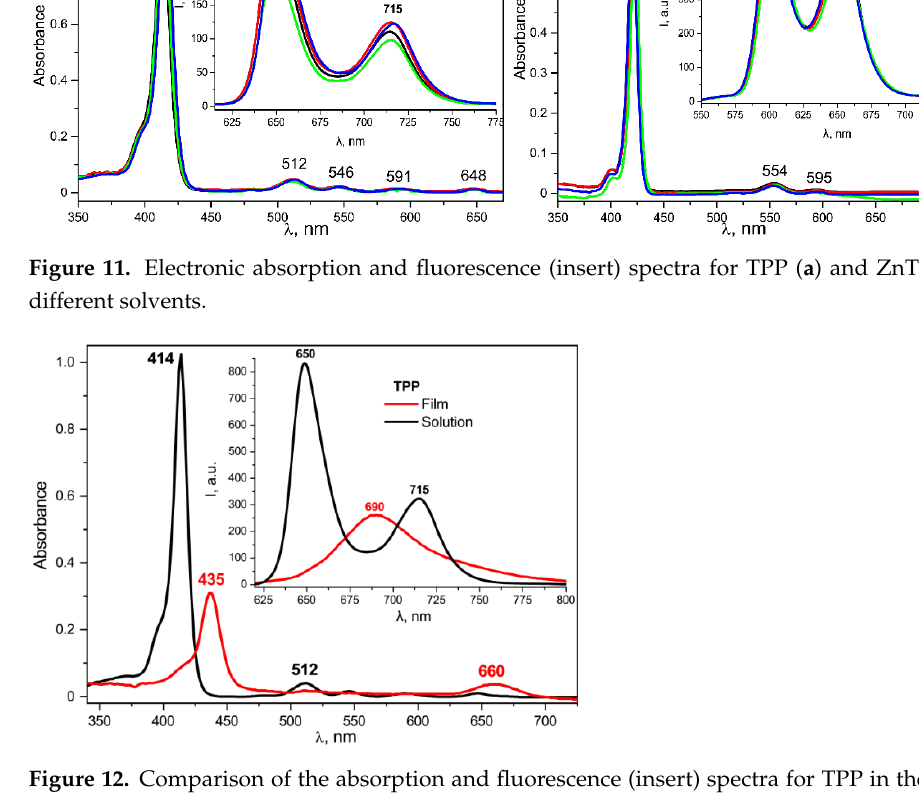
Figure 12. Comparison of the absorption and fluorescence (insert) spectra for TPP in the acetone solution and in the copolymer film crystallized from acetone.